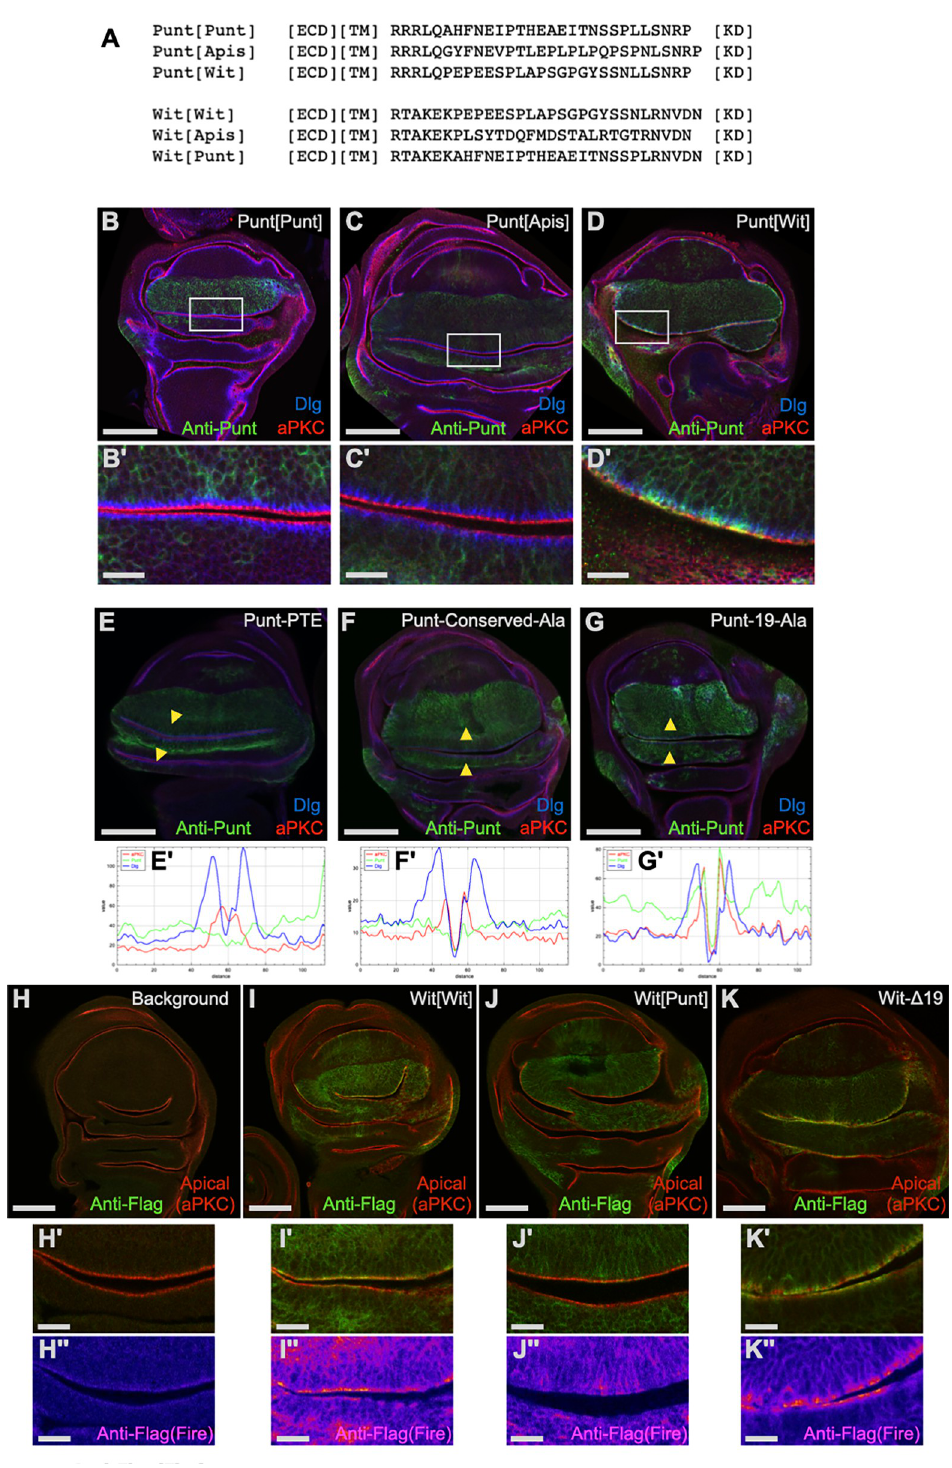
Fig 4. Punt BLT activity is conserved in insects, is robust to mutations, and is a dominant basolateral determinant in the wing disc. (A) Amino acid sequences of the juxtamembrane substitution constructs. The backbone protein is indicated with the incorporated BLT region indicated in brackets. Punt[Apis] and Wit[Apis] harbor juxtamembrane sequences from the respective honeybee Type II receptor ortholog. (B–D) BLT function is conserved in insect Punt proteins. A9-Gal4 driving the control UAS-Punt[Punt] protein revealed the absence of staining at or apical to the